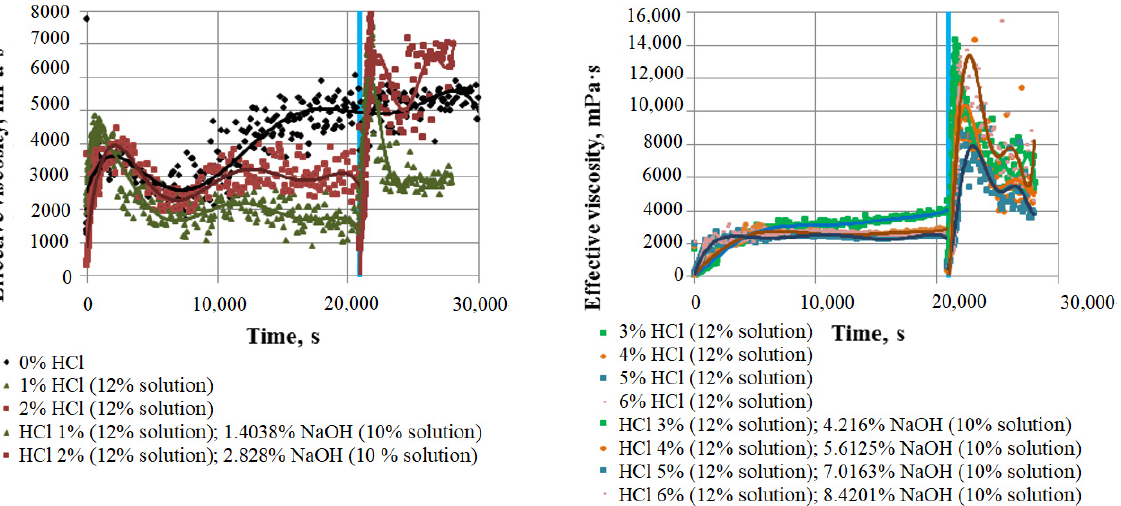
Figure 7. The dependence between the effective viscosity of the polymer composition (HPAN 4%, Cr(CH 3 COO)3 0.4%) and the concentration of the gelation delayer and neutralizer over time. The blue line indicates the moment of adding NaOH.